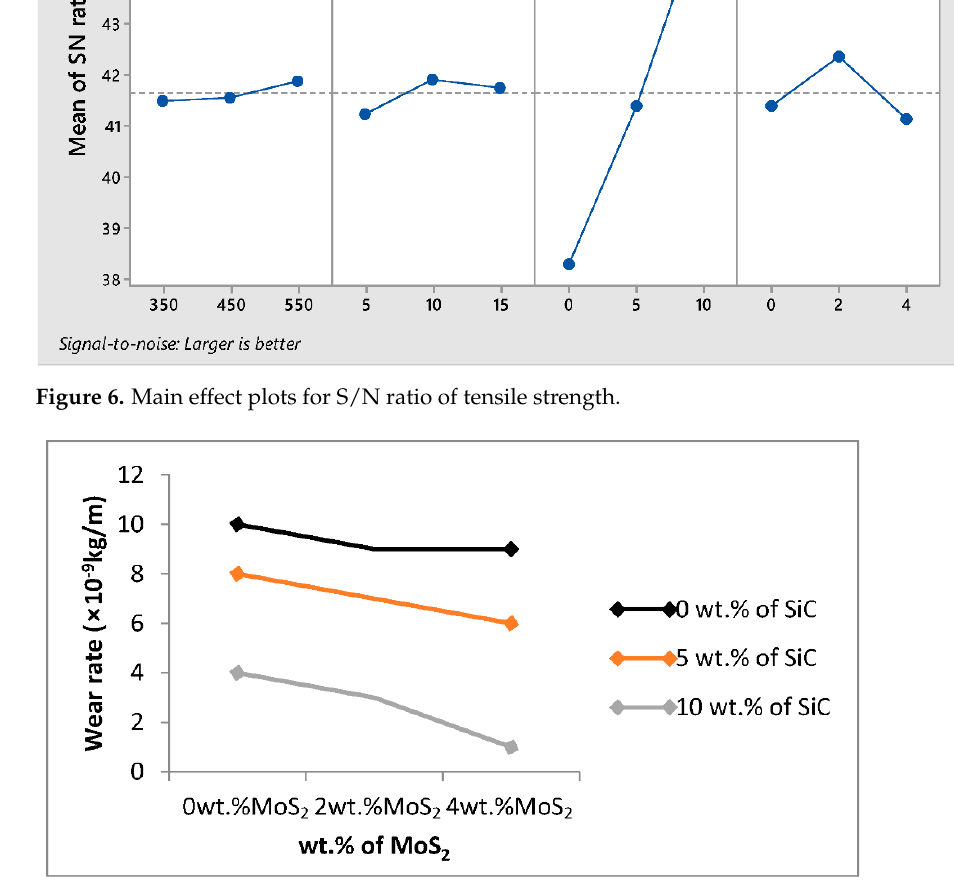
Figure 6. Main effect plots for S/N ratio of tensile strength.